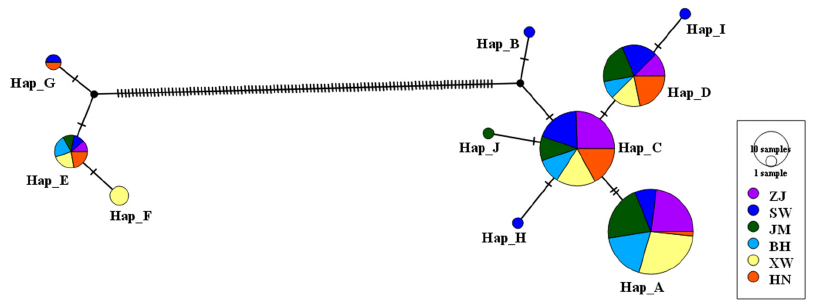
Figure 2. A TCS network showing the genetic relationships for the mitochondrial 12S gene fragment among six Chinese populations of Mytella strigata . The male mitochondrial lineage is on the left and the female one is on the right.